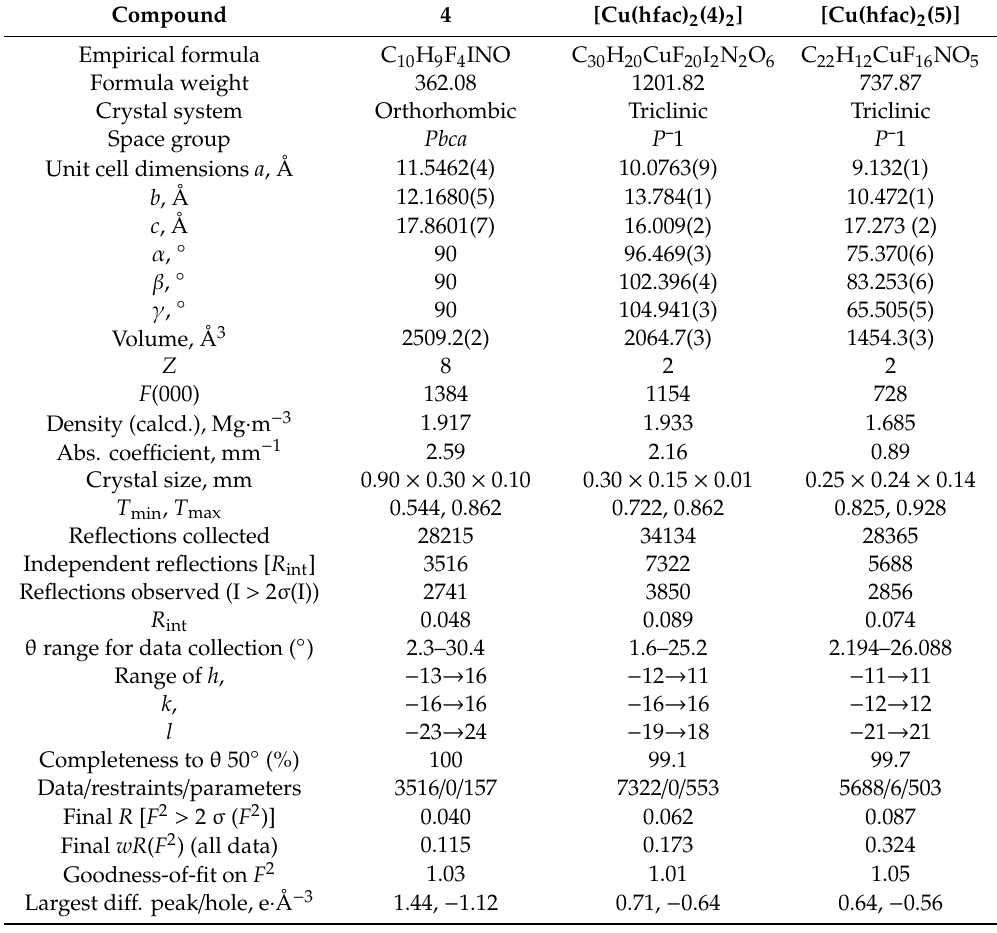
Table 1. XRD data for compounds 4 , [Cu(hfac) 2 ( 4 ) 2 ] and [Cu(hfac) 2 ( 5 )].